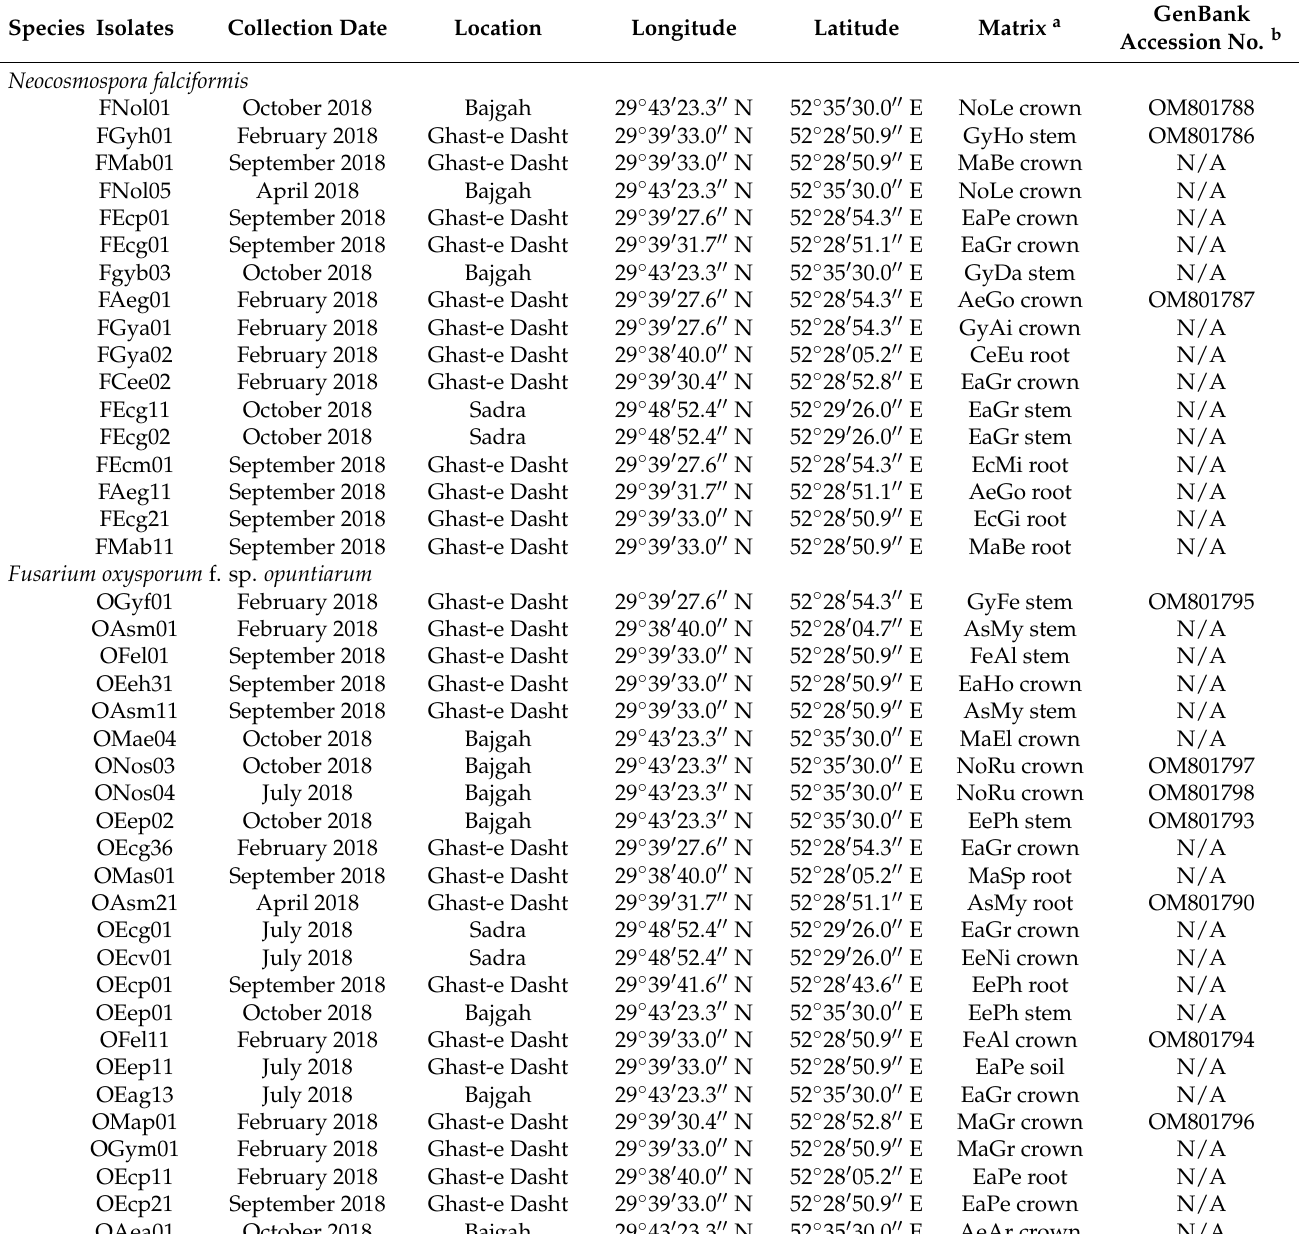
Table 1. Fusarioid species isolates recovered from ornamental cacti and other succulent plants collected in commercial greenhouses of Shiraz County,